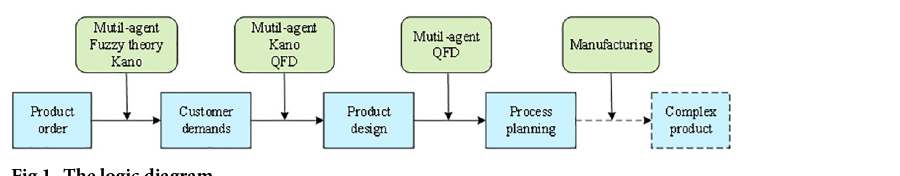
Fig 1. The logic